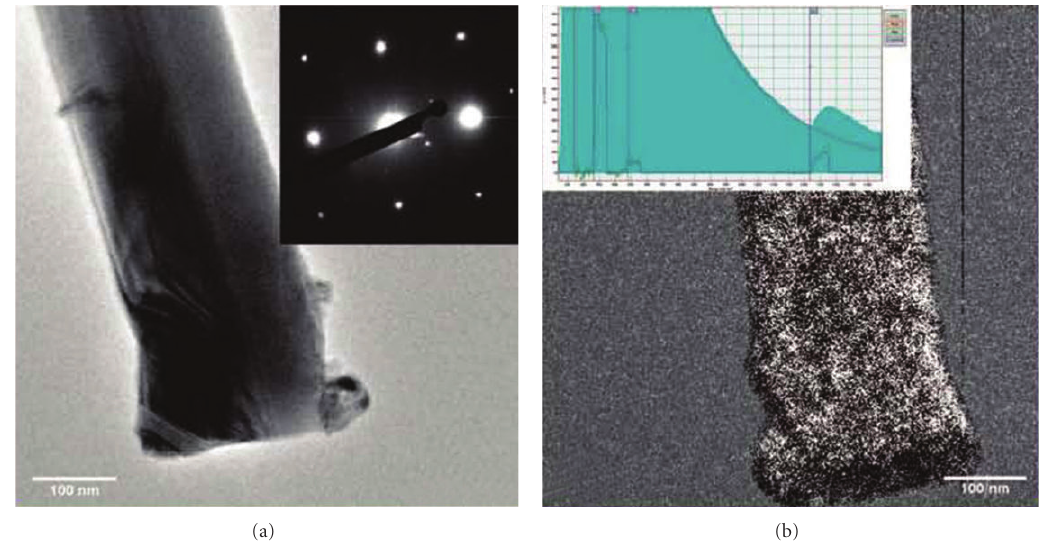
Figure 20: (a) A bright-field TEM image of a 180 nm GeMn NW. Inset is the electron di ff raction pattern of the NW. (b) Mn map of a 180 nm GeMn NW in (a) obtained by EELS mapping. Inset is the EELS spectrum, indicating the presence of the Mn peak at L-edge. Reproduced from [23]. Copyright ©2009 American Chemical